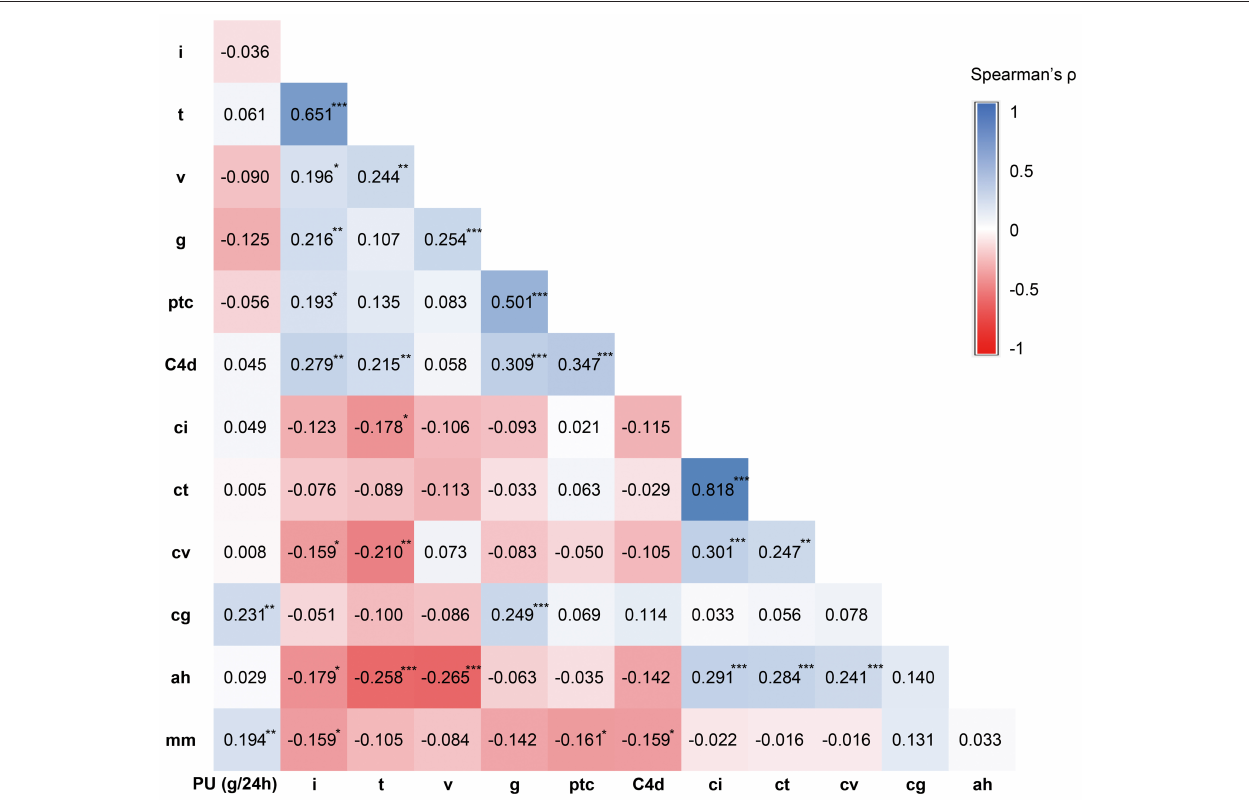
FIGURE 3 | Correlation analysis results between proteinuria level and Banff lesion scores. The relationship between proteinuria level and Banff lesion scores were analyzed using Spearman correlation analysis. The correlation coefficient Spearman’s ρ was shown in the graph. * P < 0.05, ** P < 0.01, *** P < 0.001.